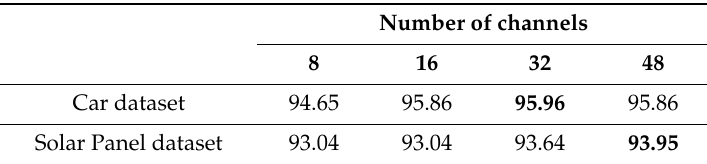
Table 3. Accuracy versus the number of channels in primary caps: Left: Car dataset, Right: Solar Panel dataset.